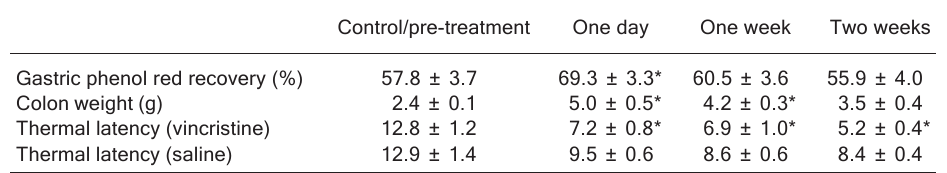
of 150 μ g/kg vincristine or